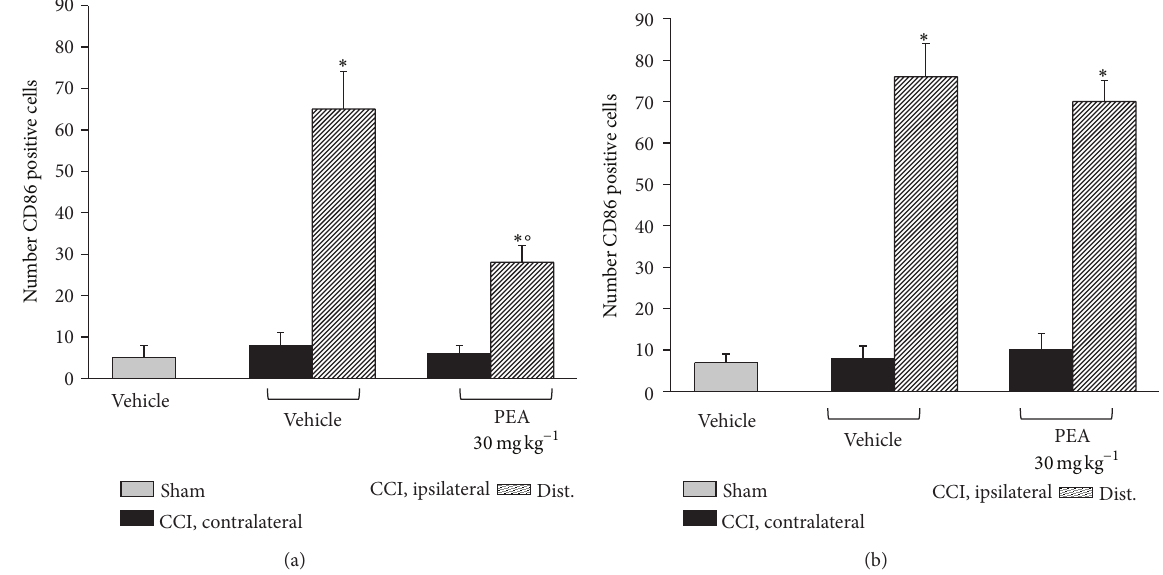
Figure 8: CD86 positive cells evaluation in sciatic nerve. 14 days after CCI, 5 𝜇 m sections of the formalin-fixed distal part of the sciatic nerve underwent immunohistochemical staining for CD86. Effect of PEA repeated treatments (30mgkg −1 s.c. daily) was evaluated in (a) PPAR- 𝛼 +/+ and in (b) PPAR- 𝛼 −/− mice, and quantitative analysis was performed evaluating 5 animals for each group. ∗ 𝑃 < 0.05 was considered as significantly different from sham, vehicle-treated mice. ∘ 𝑃 < 0.05 was considered as significantly different from CCI, vehicle-treated mice.